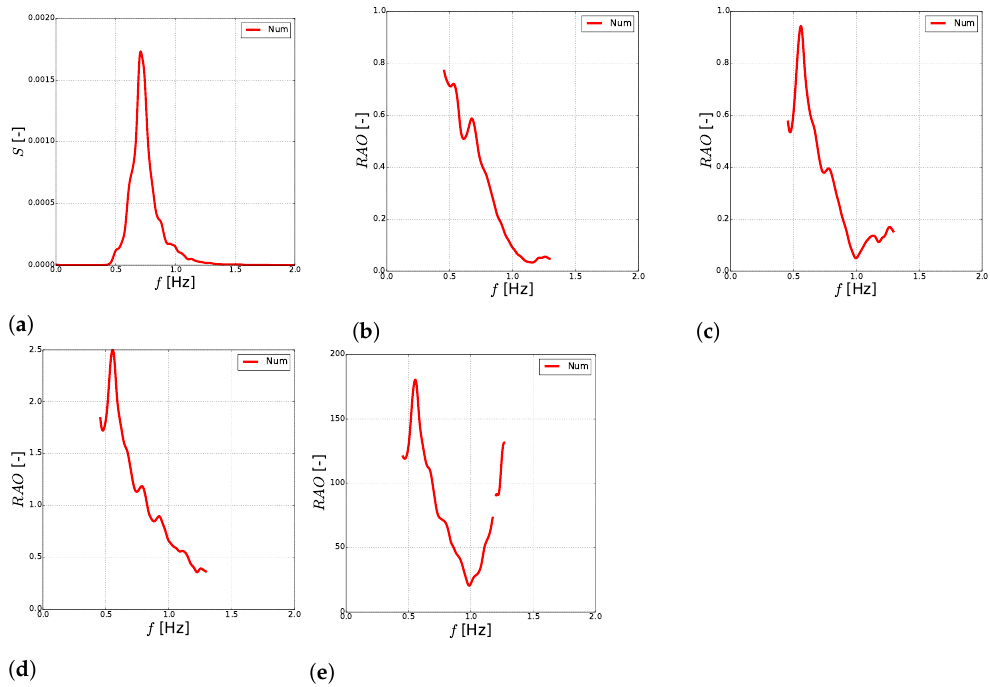
Figure 6. Wave spectrum and response amplitude operators for the simulation of the OOA structure in waves. ( a ) Wave spectrum, ( b ) Heave RAO, ( c ) Surge RAO, ( d ) Pitch RAO, ( e ) Front mooring force in x-direction